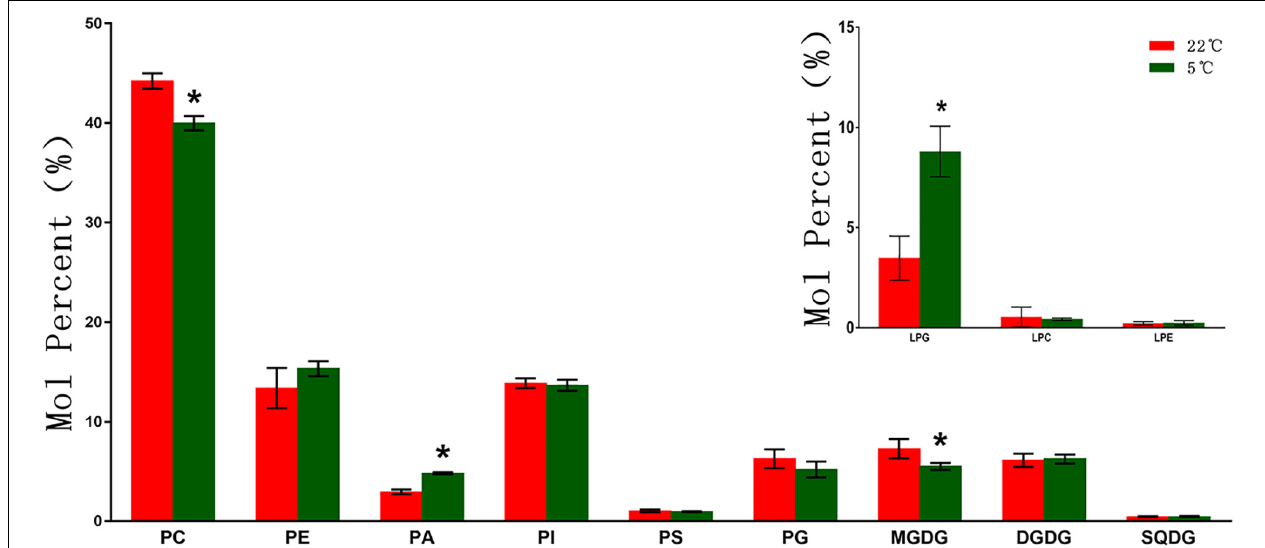
FIGURE 1 | Changes of glycerolipids species in maize roots under cold stress (5 ◦ C). PC, phosphatidylcholine; PE, phosphatidylethanolamine; PA, phosphatidic acid; PI, phosphatidylinositol; PS, phosphatidylserine; PG, phosphatidylglycerol; MGDG, monogalactosyldiacylglycerol; DGDG, digalactosyldiacylglycerol; SQDG, sulfoquinovosyldiacylglycerol; LPC, Lyso -PC; LPA, Lyso -PA; LPG, Lyso -PG. Values (mol%) are means 5 ± standard deviation (SD) ( n = 5). “*” indicated that the value was significantly different from the control ( P <